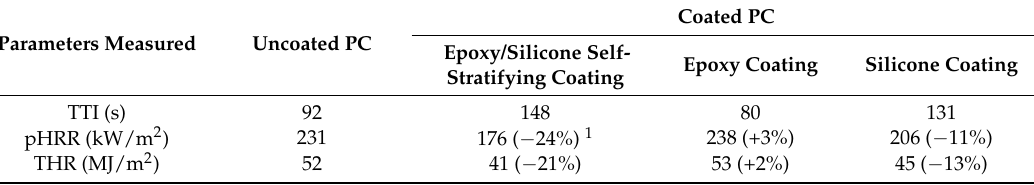
Figure 5. HRR curves obtained with uncoated PC and coated PC with the self-stratified epoxy/silicone coating, the epoxy coating and the silicone coating alone. Table 3. MLC values obtained at 50 kW/m 2 with uncoated and coated PC with the epoxy/silicone self-stratifying coating, the epoxy and the silicone coating solely.